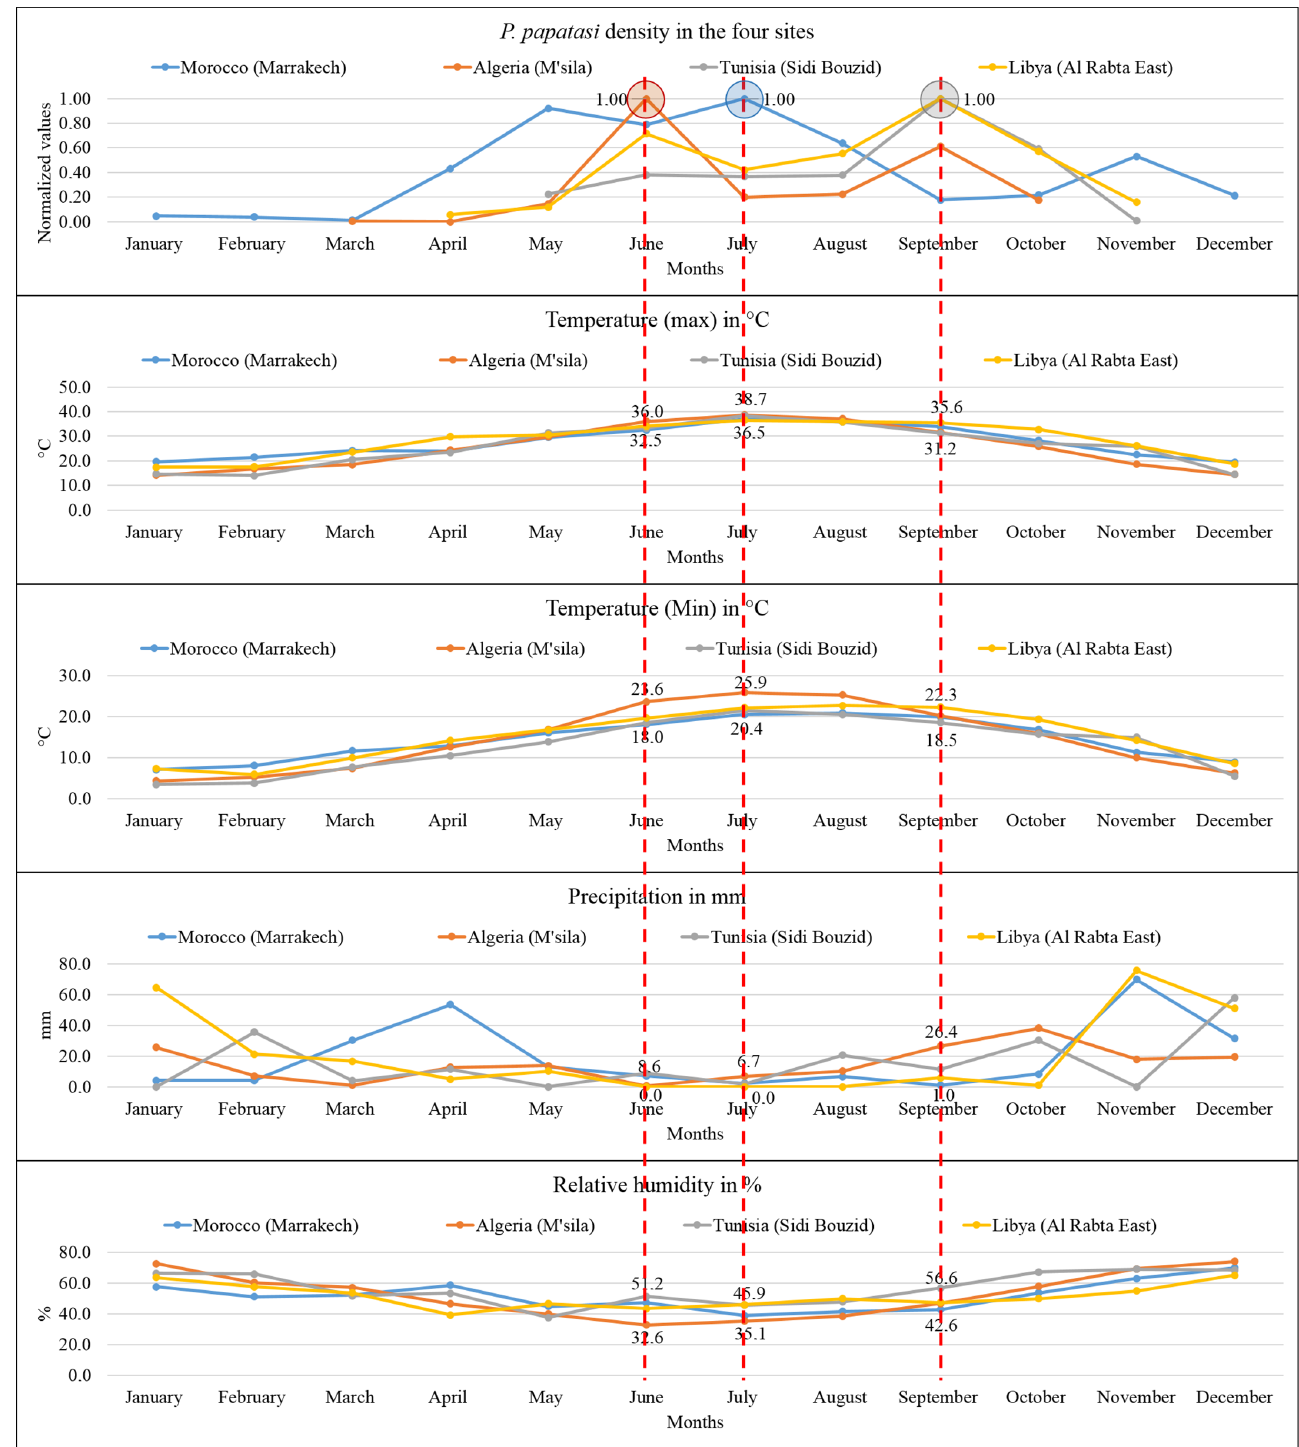
Figure 9. Association between P. papatasi activity and climatic variables in the four studied sites, including from top to down; monthly P. papatasi activity, monthly maximum and minimum temperatures in °C, monthly precipitation in mm, and monthly relative humidity in %. Red dotted lines indicate the association between the peaks of P. papatasi density and climatic parameters. These findings support that P. papatasi activity occurs during the hot season, where both minimum and maximum temperatures are high, and low temperatures during the